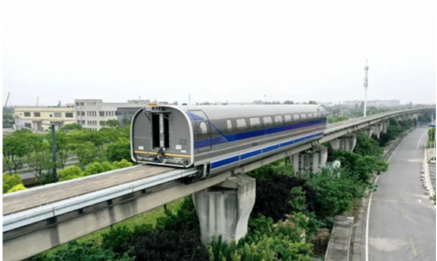
Figure 6. Magnetic levitation transportation test line at Tongji University’s Jiading campus.